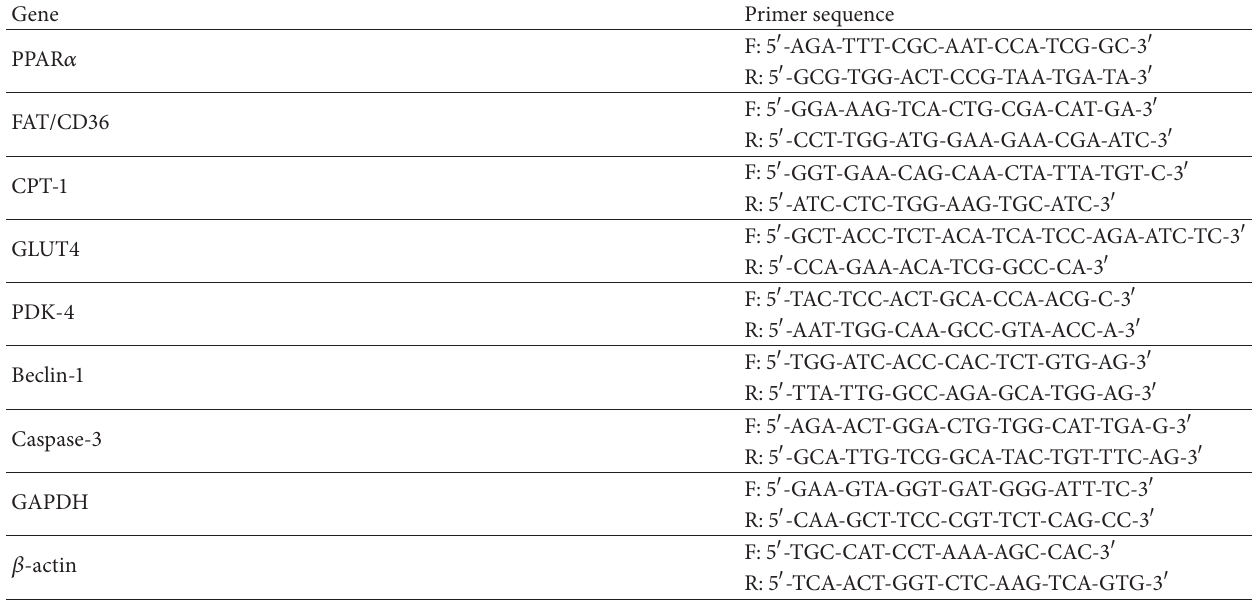
Table 2: Primers used for quantitative real-time polymerase chain reaction.